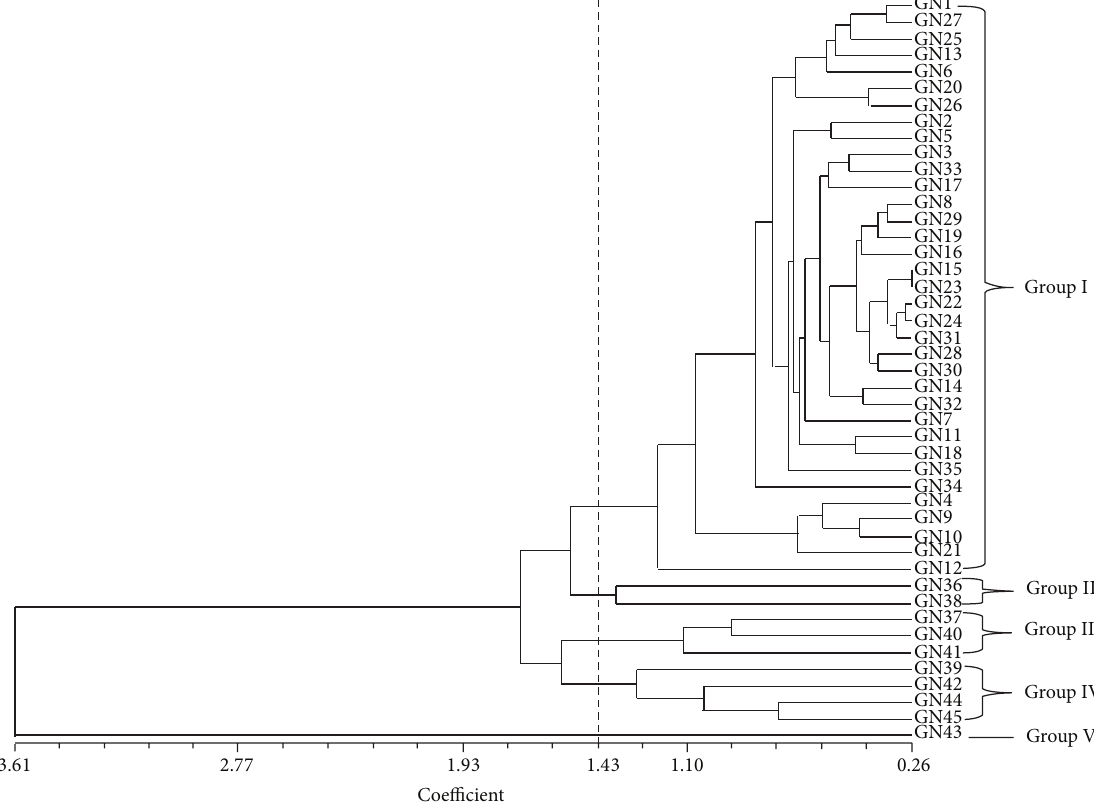
Figure 1: Clustering pattern of the morphological trait at dissimilarity coefficient of